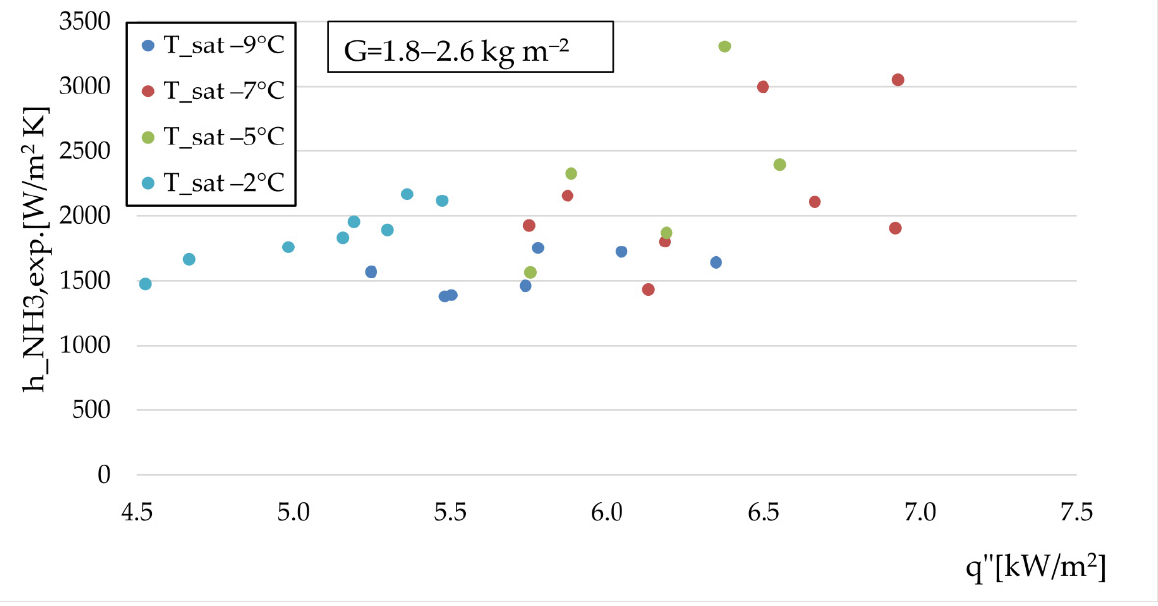
Figure 9. Experimental ammonia heat transfer coefficient for several evaporation temperatures.